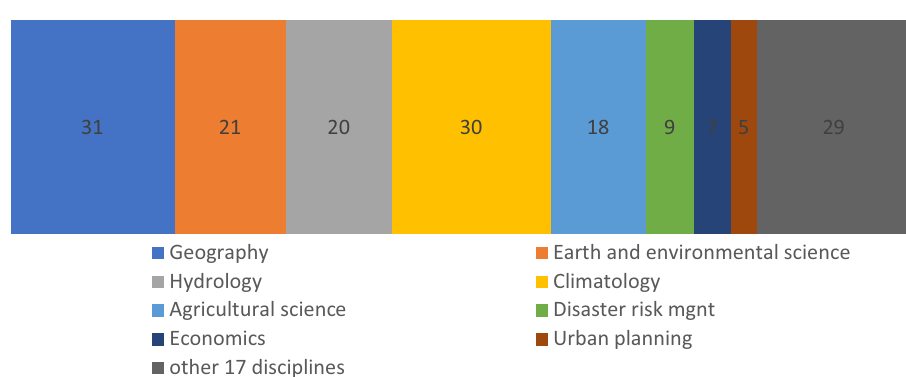
Fig. 5 Studies by